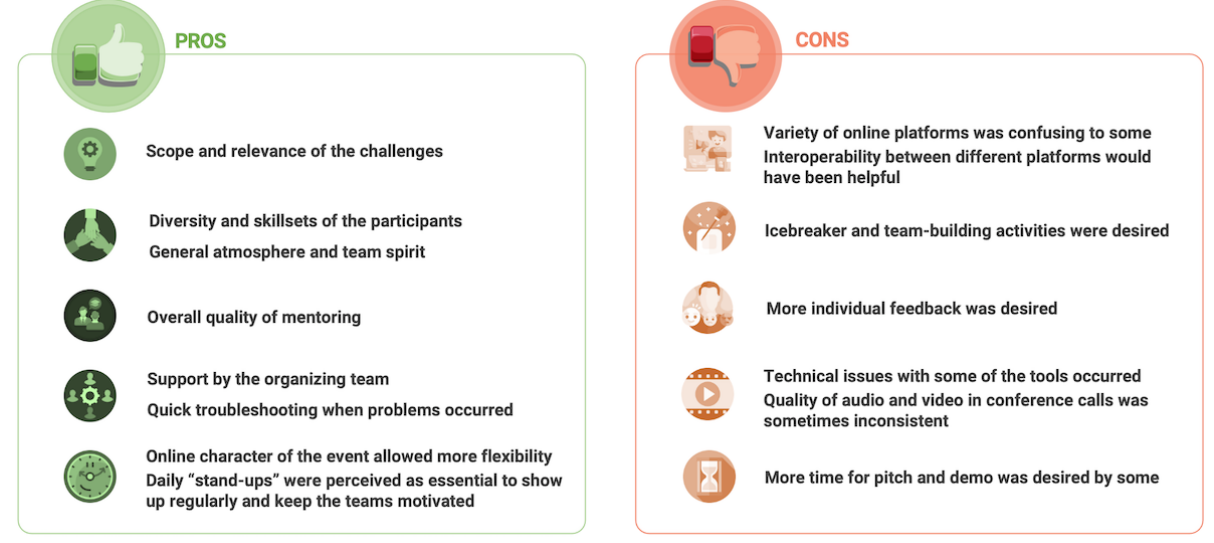
Figure 3. Experiences of participants specifically regarding the remote and online nature of the